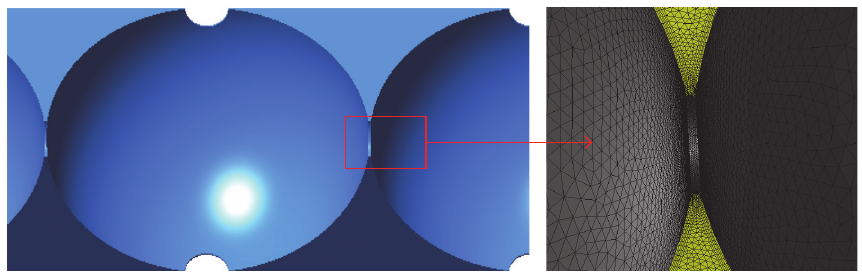
Figure 3: Geometry and mesh near contact